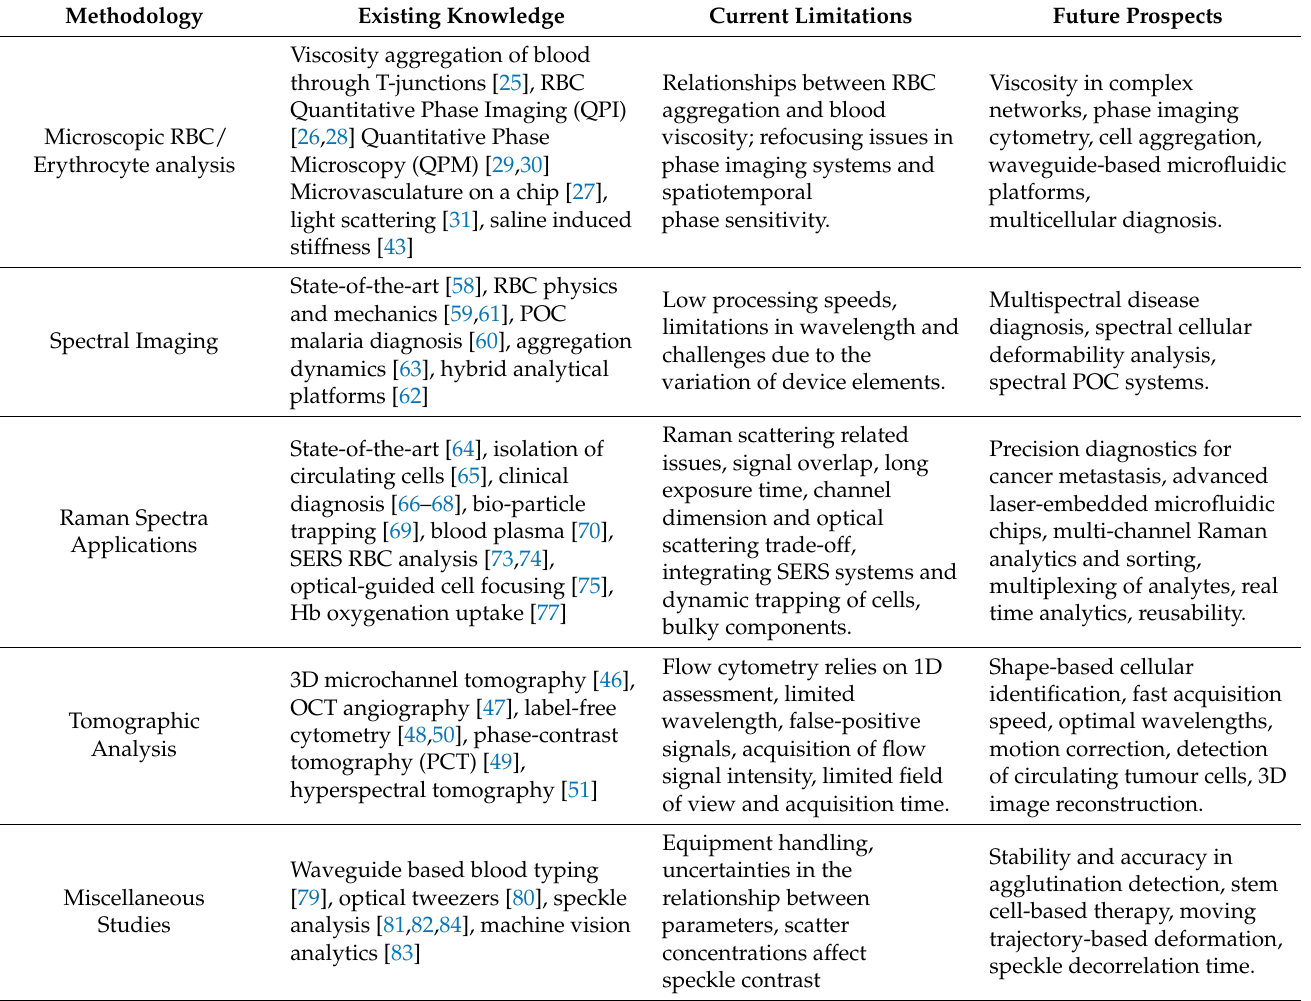
Table 1. Comparison of Existing studies and Future